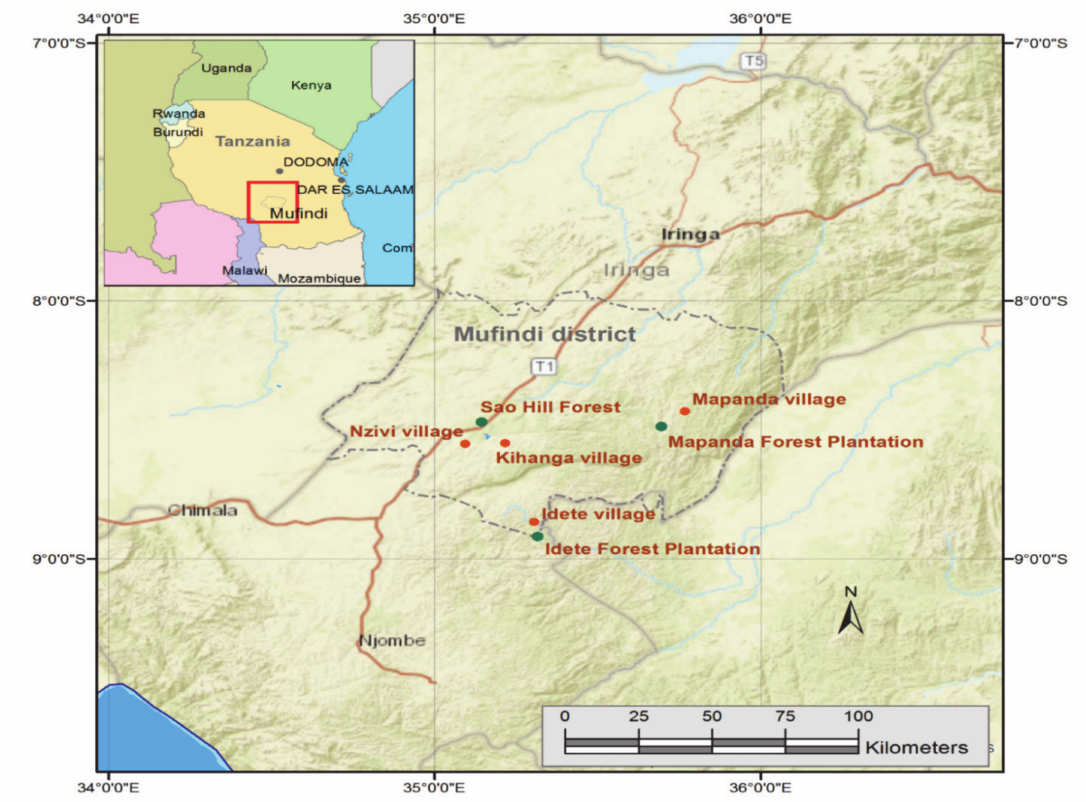
Figure 1. Map of study villages, Mufindi district,